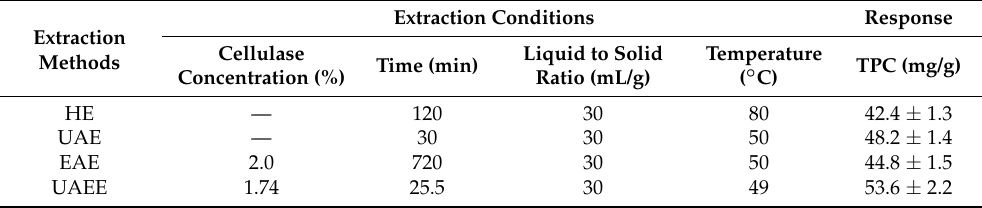
Table 3. Comparison of experimental results obtained from different extraction methods.